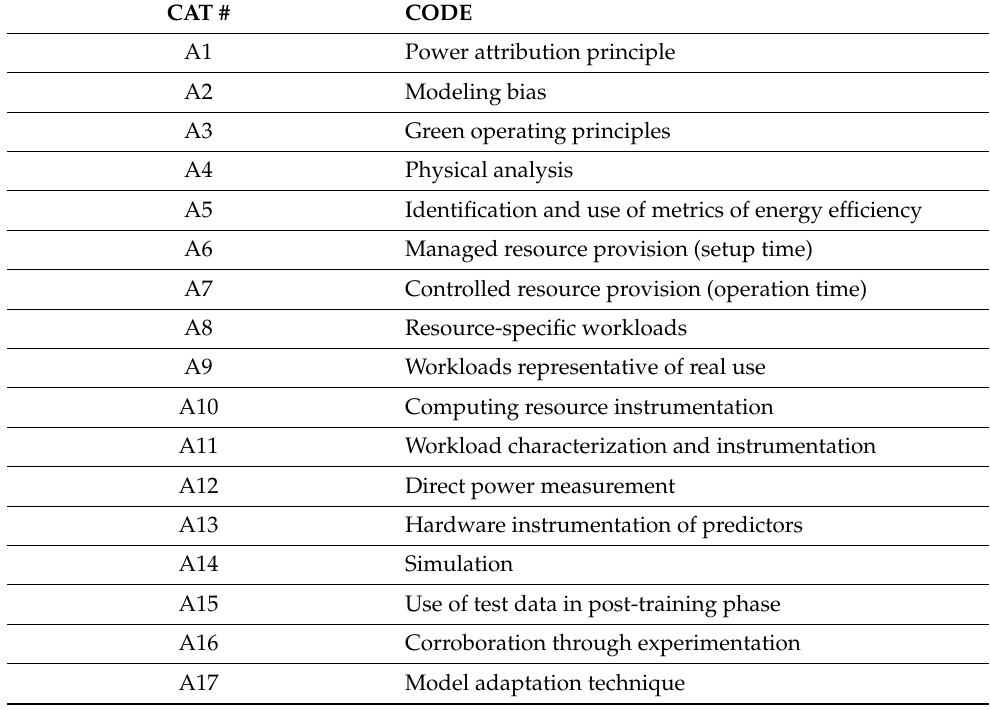
Table 3. Approach category codes.